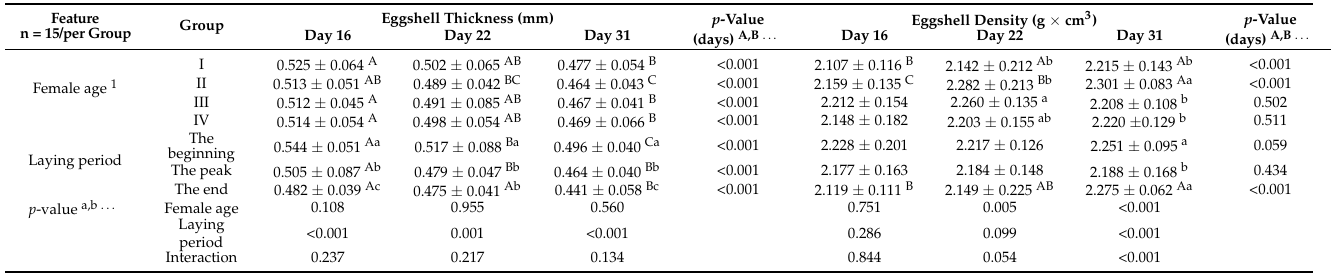
Table 4. Physical features of goose eggshell during